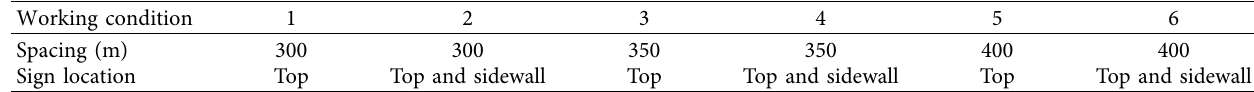
Table 2: Test scheme.